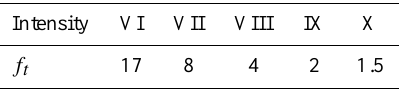
Table 2. Value of the population density factor f p . Table 3. Value of f t for night-time